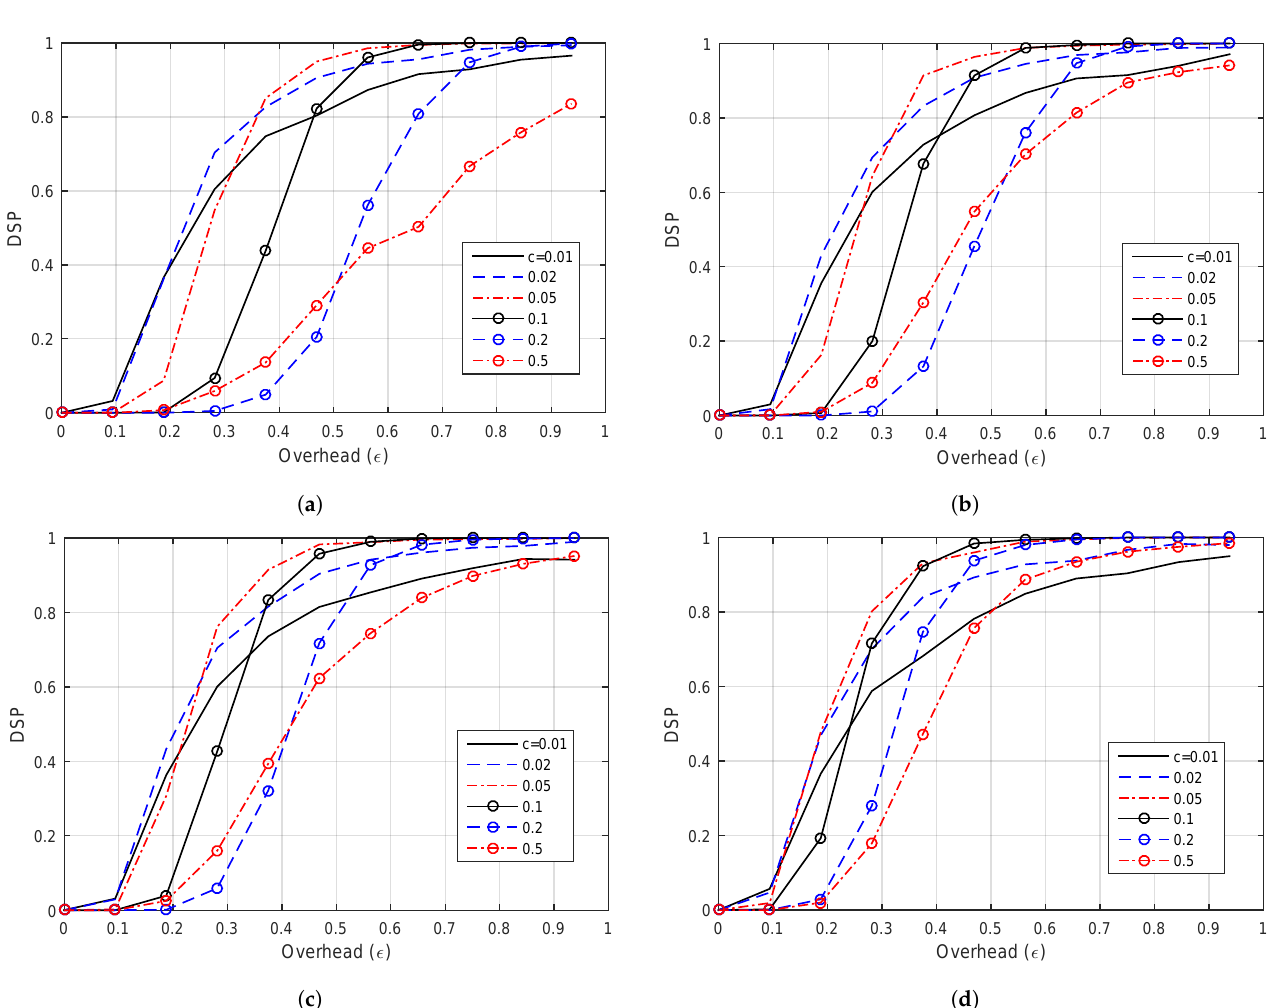
Figure 5. DSP versus the overhead ( (cid:101) ) for LT codes of k = 256 at different values of c . ( a ) δ = 0.05. ( b ) δ = 0.1. ( c ) δ = 0.2. ( d ) δ =